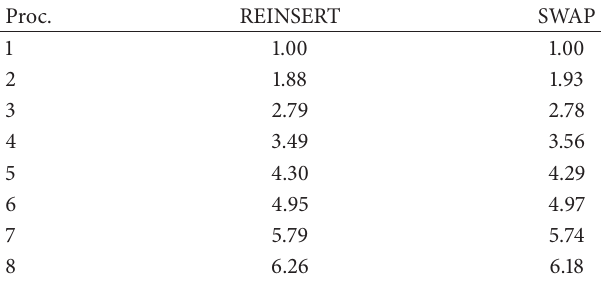
Table 12: PTS and JTS speed-up: balanced start. Proc.